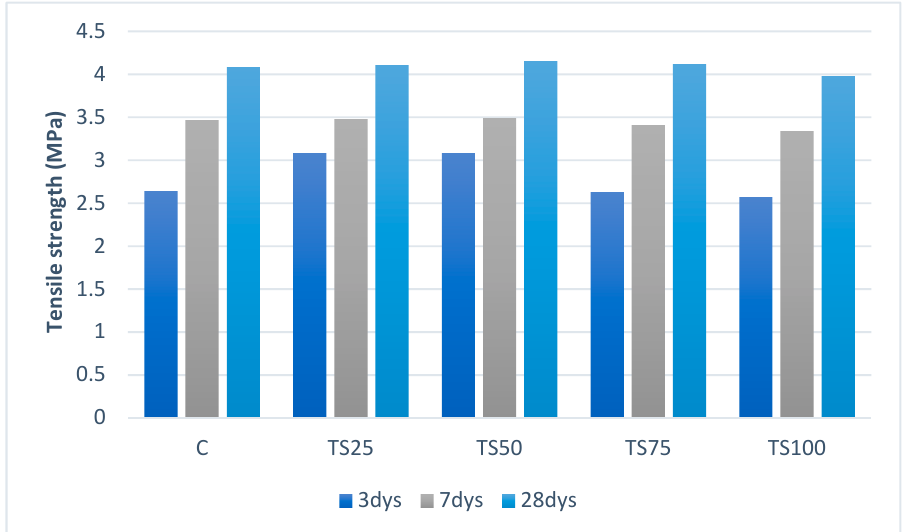
Figure 14. The tensile strength across curing days at a w / c of 0.55.